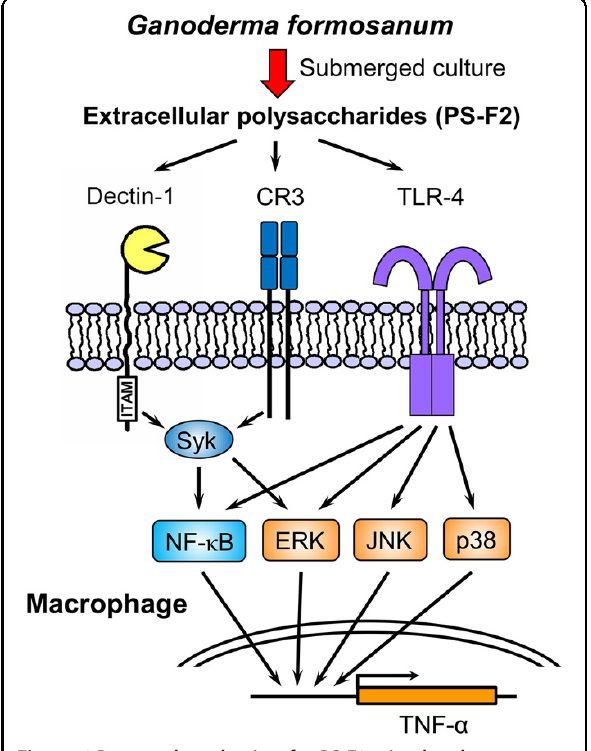
Figure 6 Proposed mechanism for PS-F2-stimulated macrophage activation. PS-F2 stimulates the activation of macrophage via the engagement of Dectin-1, CR3, and TLR4. The activation of these PRRs turned on the downstream signaling cascades involving Syk, JNK, p38, ERK and NK- κ B, resulting in macrophage activation and TNF- α